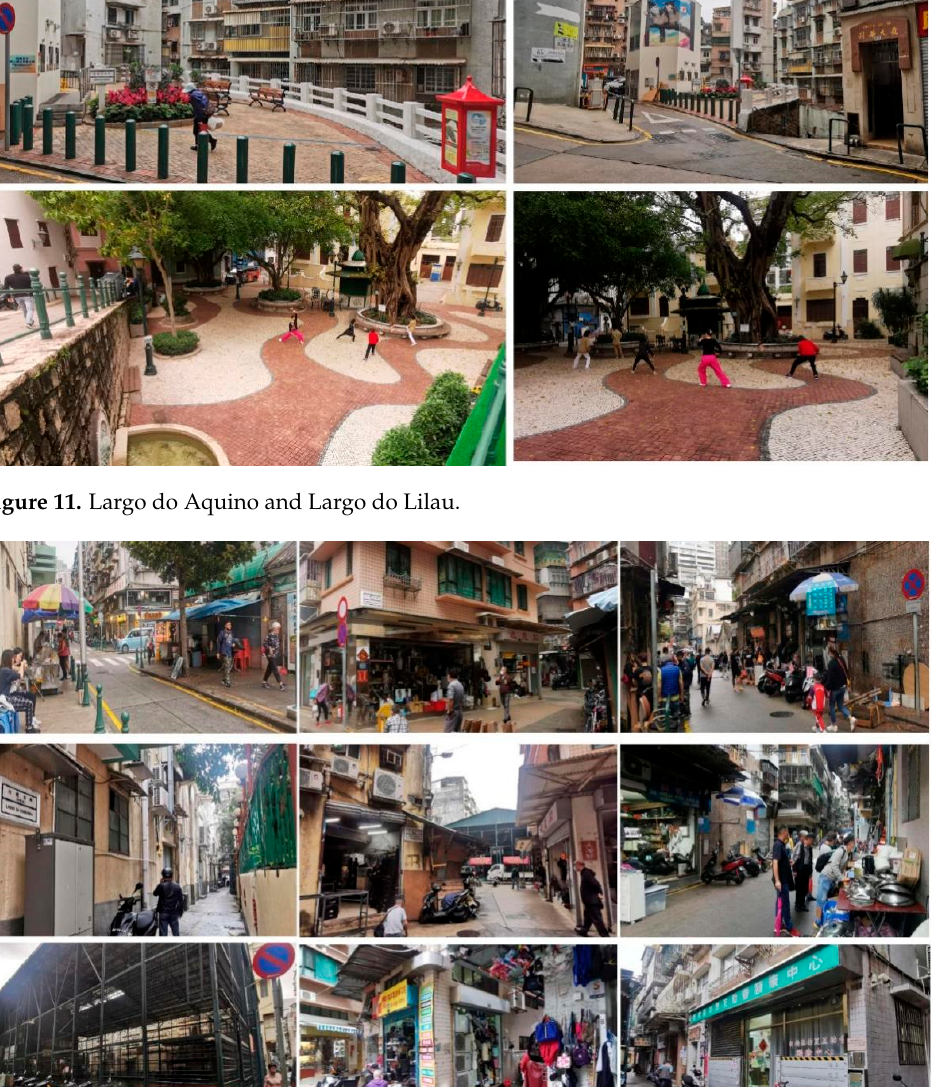
Figure 12. Largo da Cordoaria.